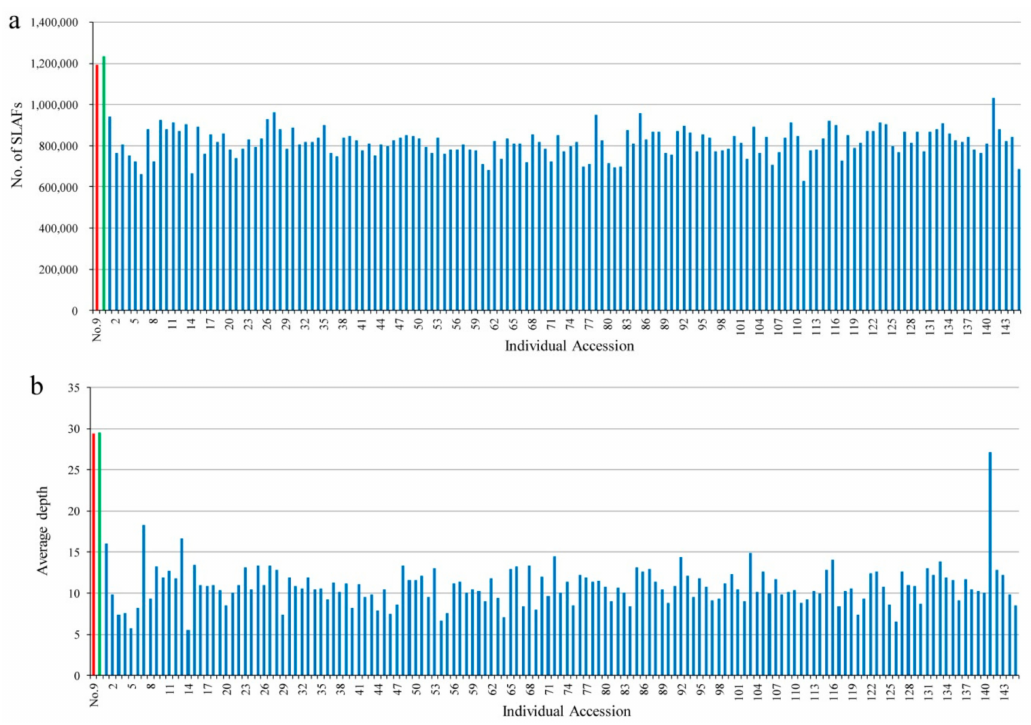
Figure 1. Number and depth of SLAFs for each F1 individual and its two parents. Horizontal axes in ( a , b ) indicate individual accessions represented by di ff erent colors, red: parent no. 9, green: parent no. 100, blue: F1 progeny individuals from 1 to 145; the vertical axis indicates the number and average depth of SLAFs in ( a , b ),